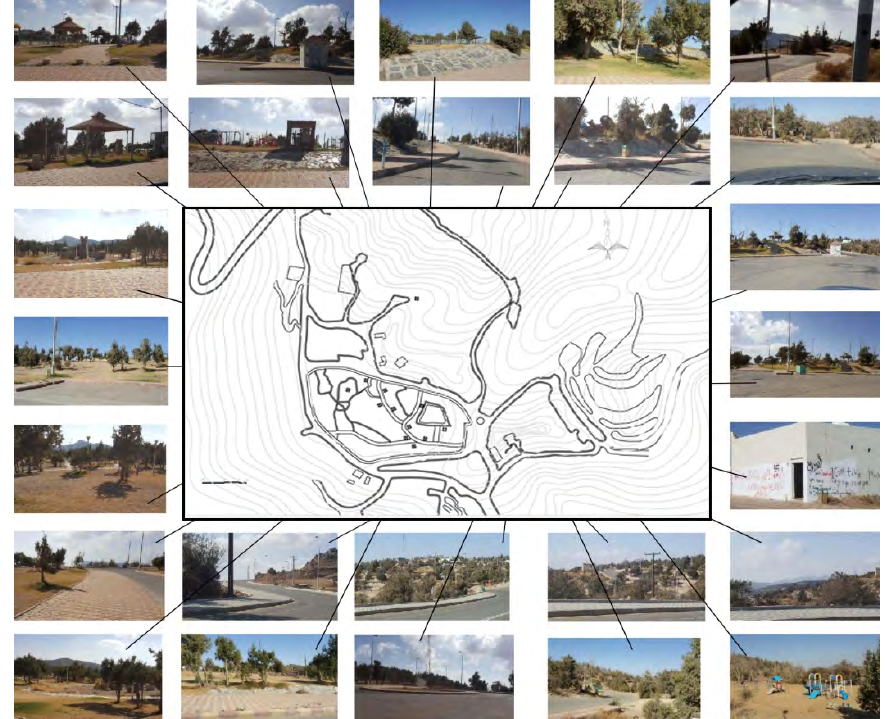
Figure 9. Master plan of thecurrent situation of Prince Meshari Park, and photographs of the park. (Source:Author).